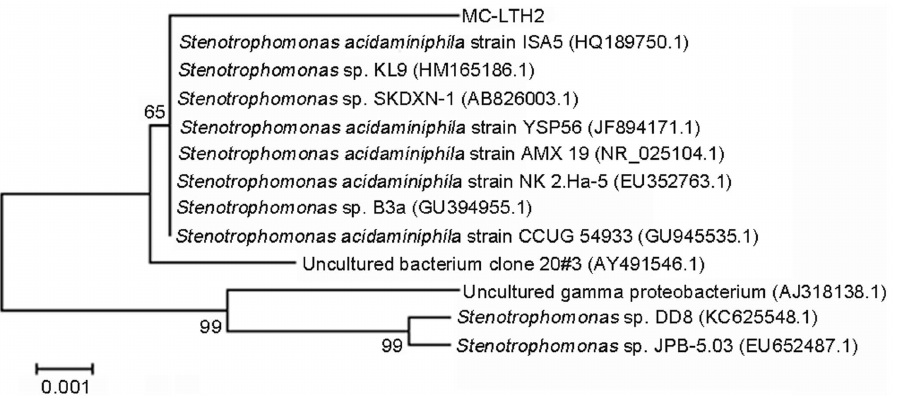
Figure 1. A phylogenetic tree based on 16S rDNA sequences of MC-LTH2 and other closely related species. The numbers at the nodes are the levels of bootstrap support (%) based on the neighbor-joining analyses of 1,000 resampled datasets. The scale bar represents 0.001 nucleotide substitutions per position.